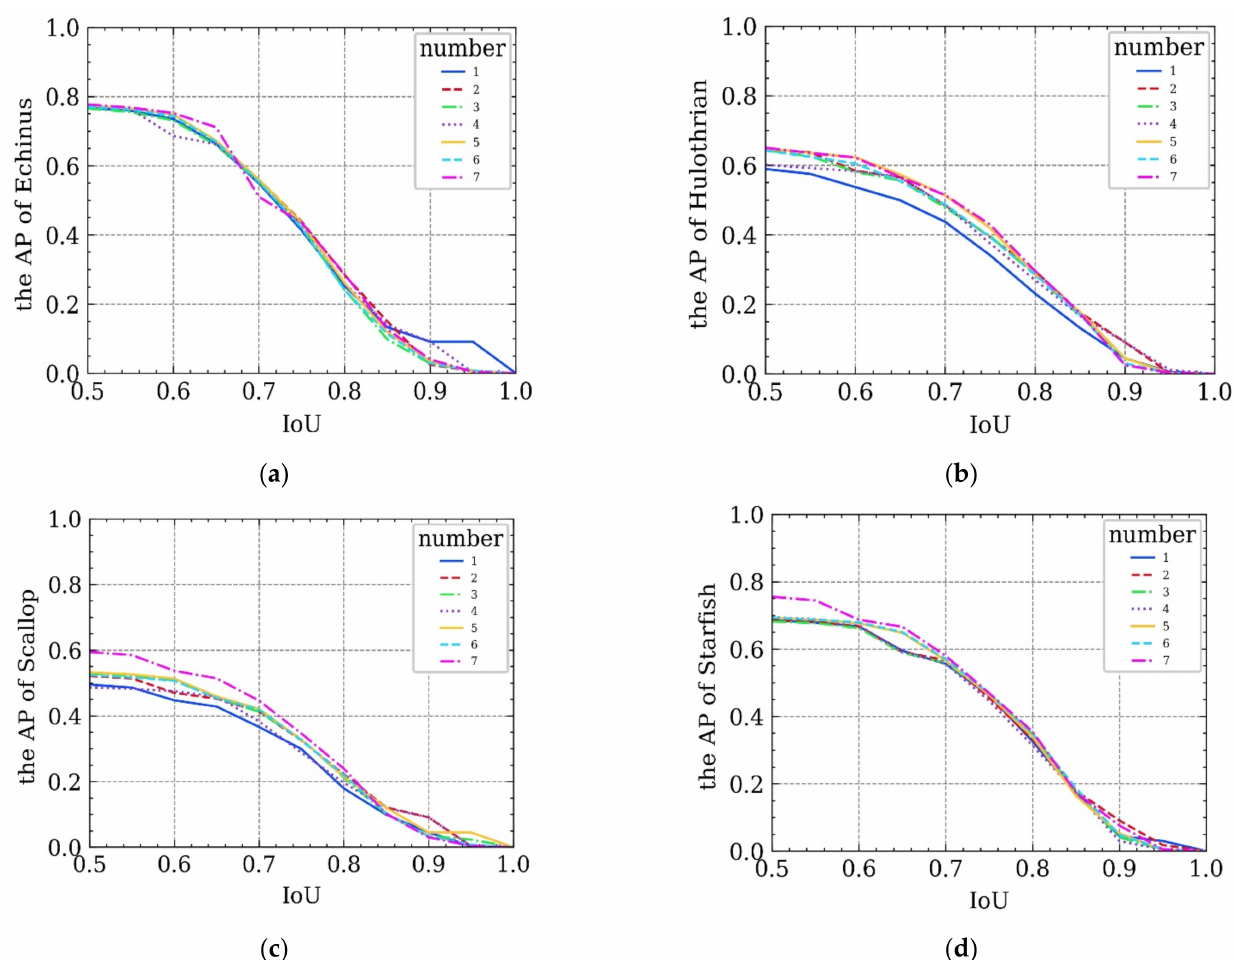
Figure 8. Ablation experiments results: ( a – d ) corresponds to the trend of the detection precision of each organism category in the data set changed with the IoU threshold during the ablation experiments in six